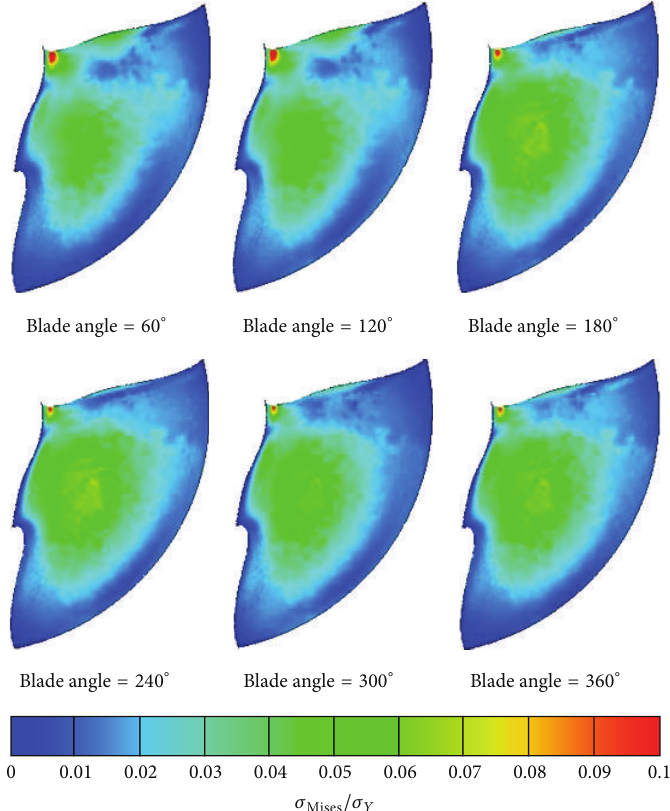
Figure 23: Normalized von Mises stress contours on the suction side of the rotor blade at various blade angles along one revolution ( 𝜎 𝑌 = 450